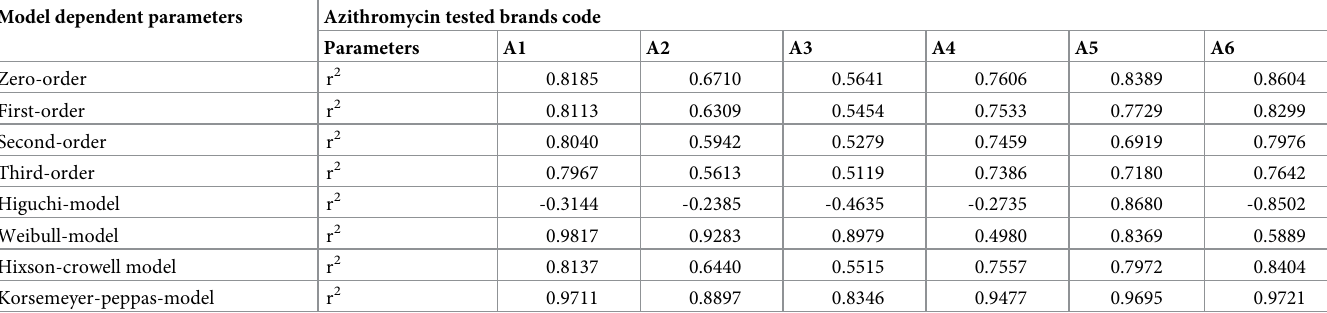
Table 13. Determination of the dissolution release kinetics by model dependent method.